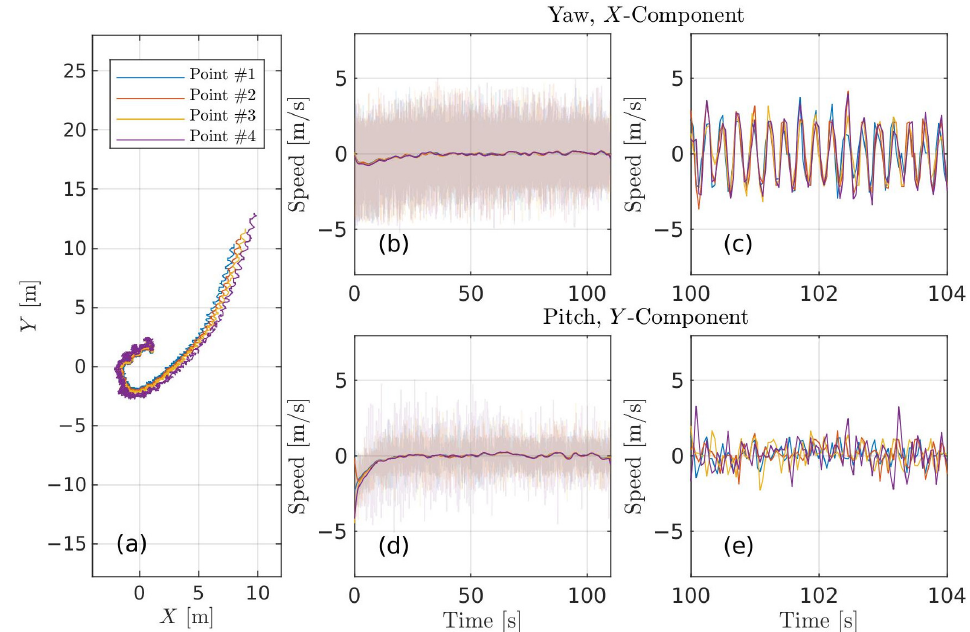
Figure 8. UAV self-stabilization quality control test from land control point tracing: ( a ) apparent drift of the control points; ( b , d ) X - and Y -projection of control point velocity (gray lines—frame- by-frame estimate, color lines—4-s time average); and ( c , e ) velocity fragment showing its high- frequency